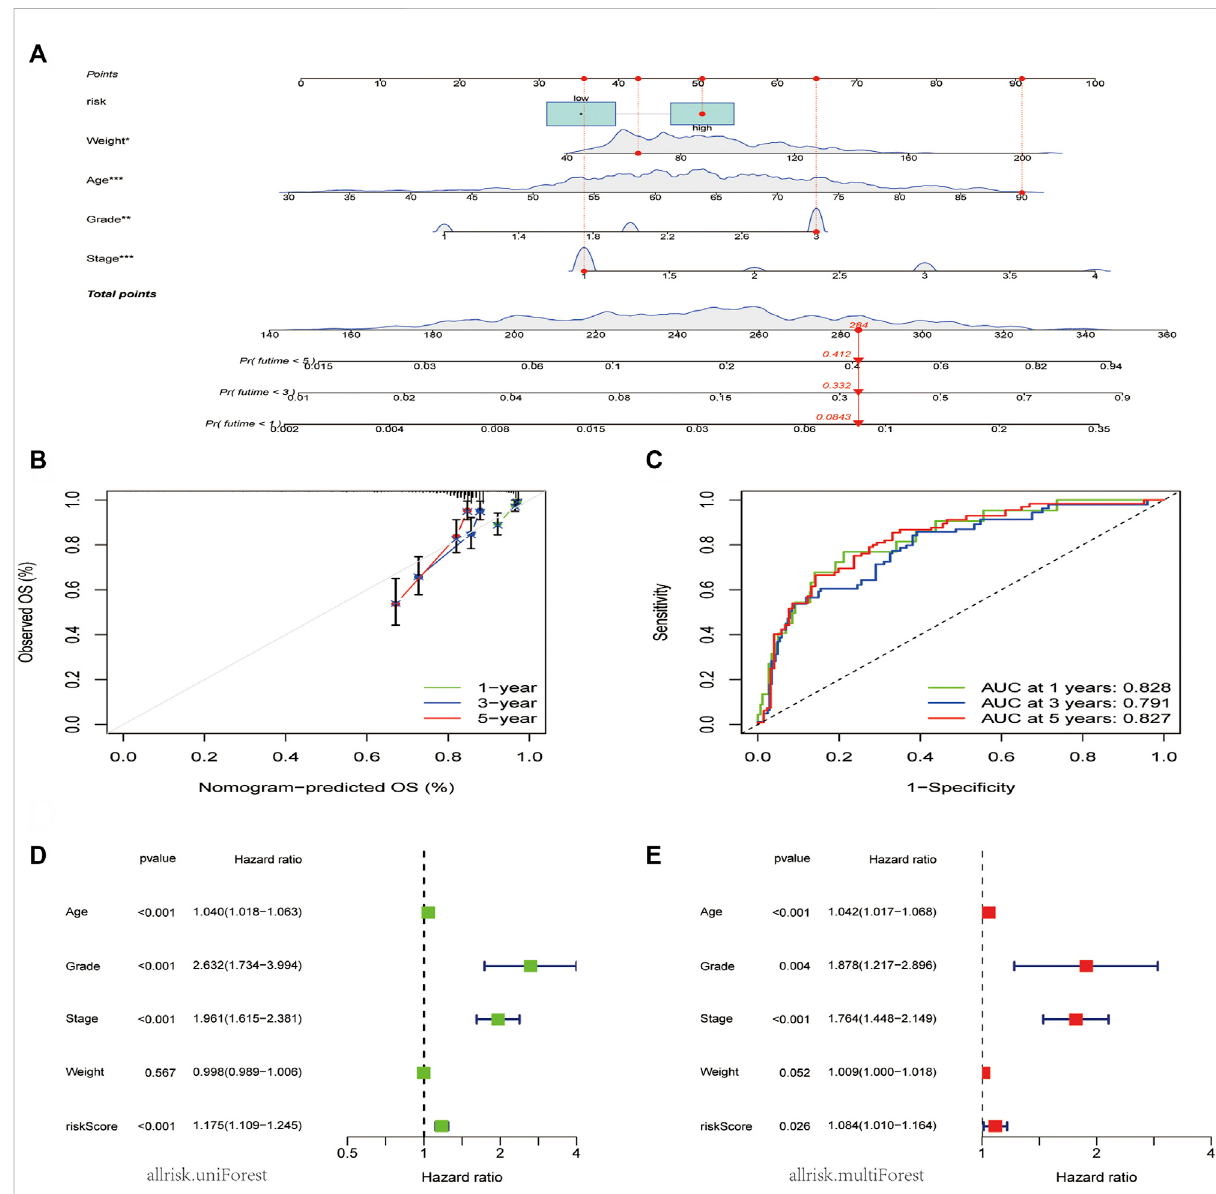
FIGURE 5 Nomogram model construction and prognostic factor analysis. (A) . A nomogram model was constructed to predict the 1-year, 3-year, and 5- years OS probabilities of patients with EC. (B) Calibration curves for the nomogram model to predict the probability of the1-year, 3-year, and 5-year OSofpatientswithEC. (C) ROCcurvesforthenomogrammodeltopredicttheprobabilityoftheyear1-year,3-year,and5-yearOSpatientswithDC. (D,E) The results of univariate (D) and multivariate Cox regression (E) for the OS of patients with EC are shown in forest